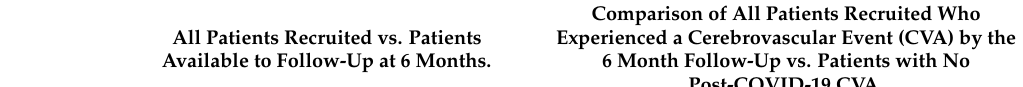
Table 1. Demographical and clinical variables of the studied population at the beginning of data collection compared to patients at the 6-month follow-up, patients who had a stroke six months later, and patients 48 h after admission. Comparison of All Patients Recruited Who All Patients Recruited vs. Patients Experienced a Cerebrovascular Event (CVA) by the Available to Follow-Up at 6 Months. 6 Month Follow-Up vs. Patients with No Post-COVID-19 CVA.